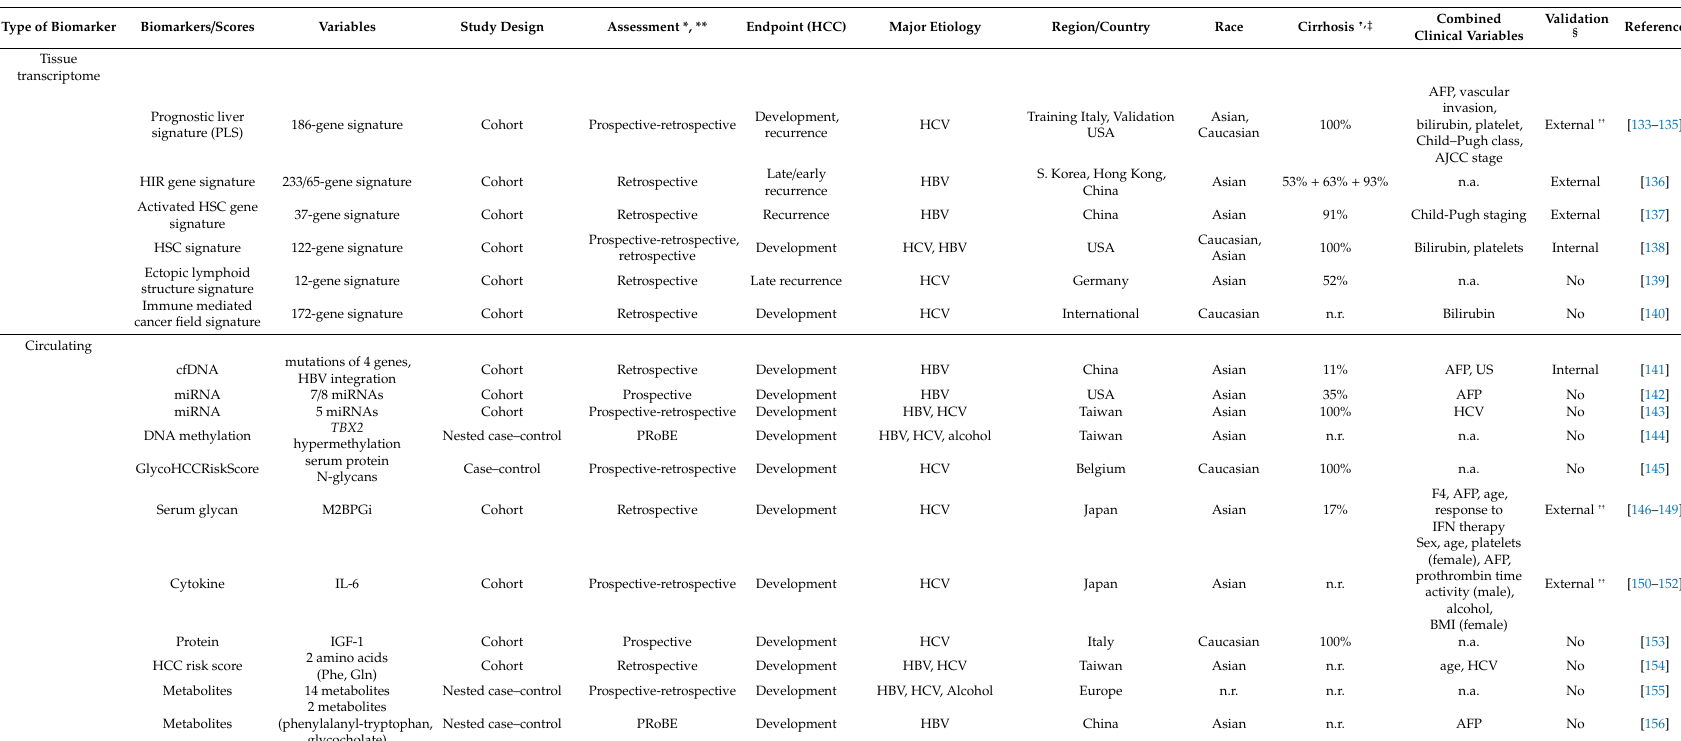
Table 2. Molecular HCC risk biomarkers.